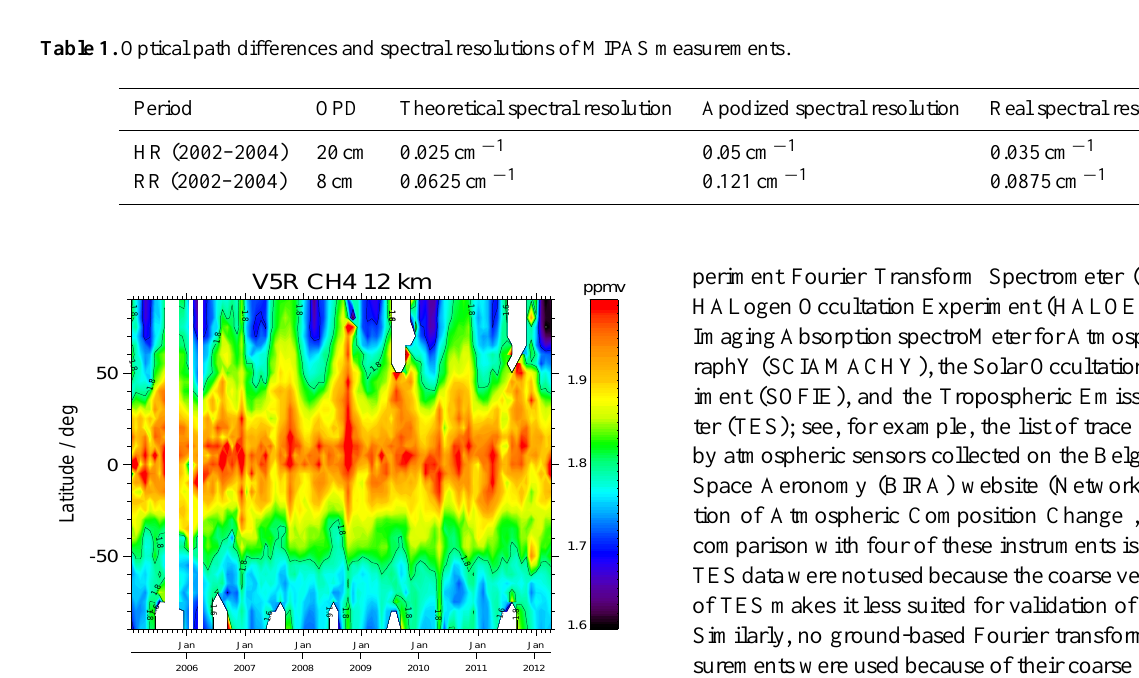
Figure 1. Temporal evolution of latitudinal distribution of CH 4 vmrs at 12km as seen by MIPAS.